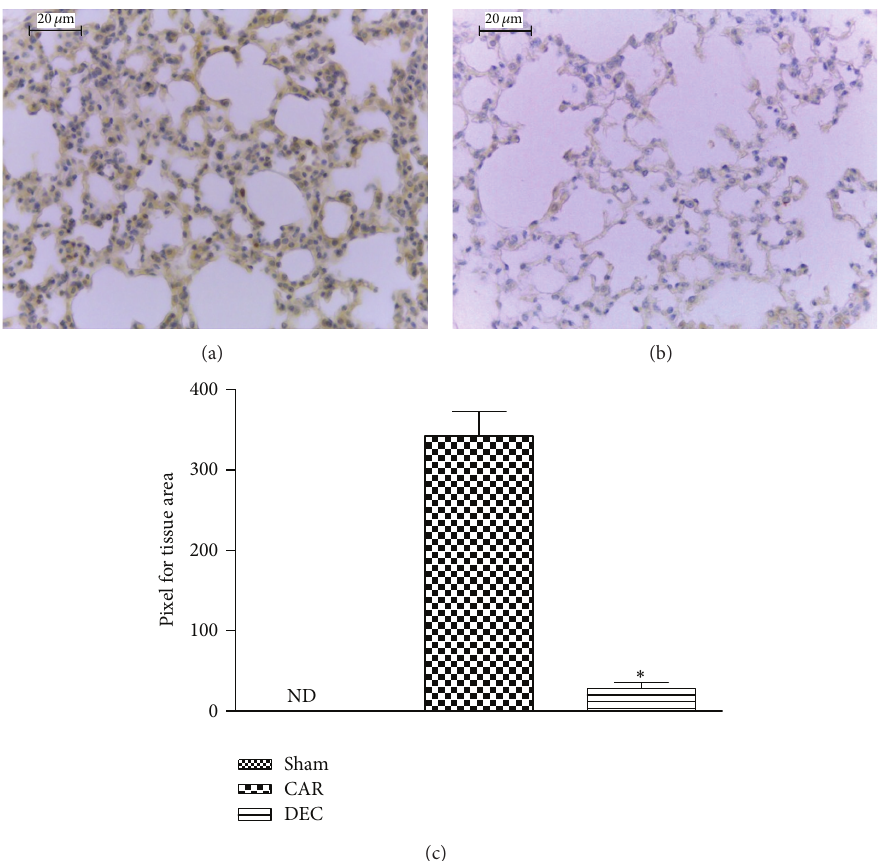
Figure 5: Effect of DEC on immunohistochemical localization TNF- 𝛼 in lung after carrageenan-induced pleurisy. (a) In tissue sections obtained from the CAR group, positive staining for TNF- 𝛼 was mainly located in inflammatory cells. (b) After treatment with DEC, the degree of positive staining for TNF- 𝛼 was reduced in the lung tissue. (c) Densitometry analysis of immunohistochemistry photographs for TNF- 𝛼 in lung tissues; figure representative of at least 3 experiments performed on different experimental days; data expressed as mean ± S.E.M. from 𝑛 = 5 mice for each group; ND: not detected; ∗ 𝑃 < 0.05 versus carrageenan; scale bar = 20 𝜇